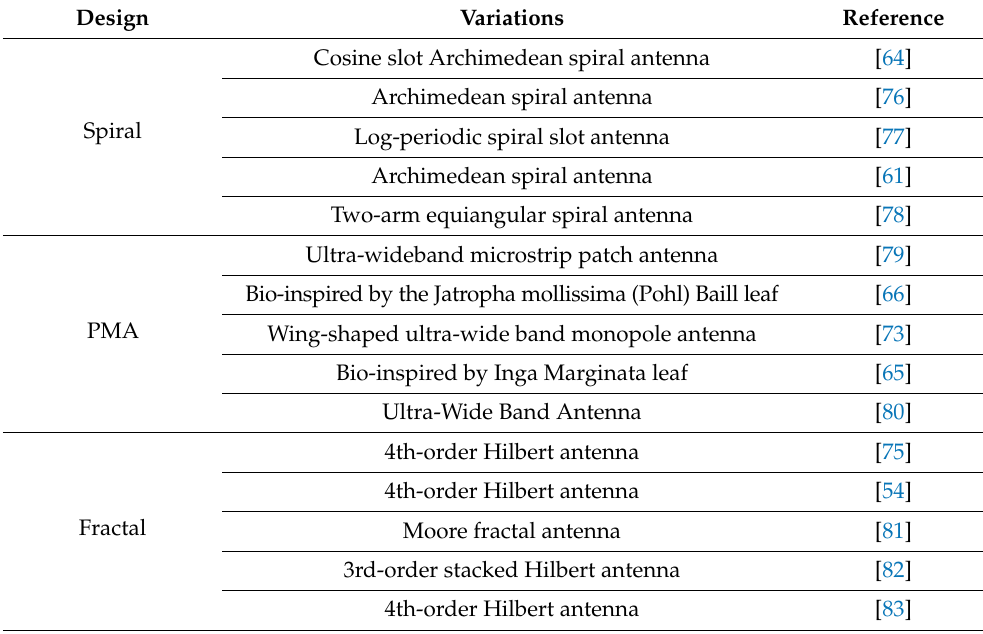
Table 3. Antenna designs and their respective